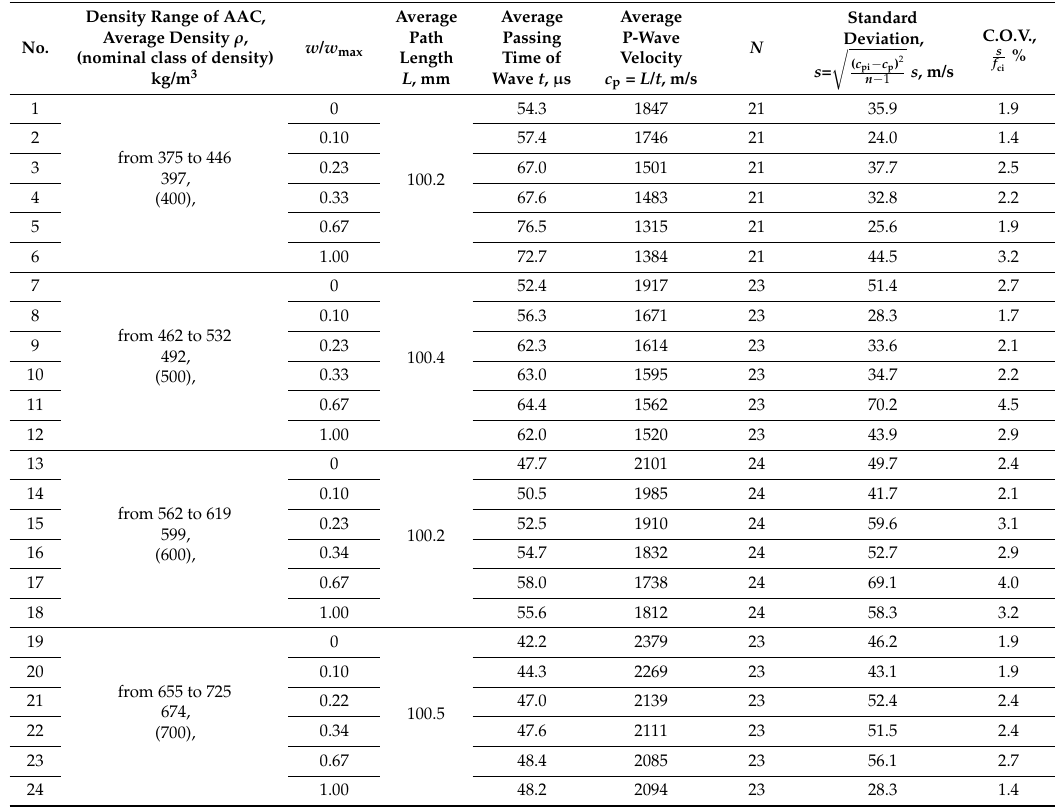
Table 6. Test results for ultrasound velocity in AAC with varying moisture